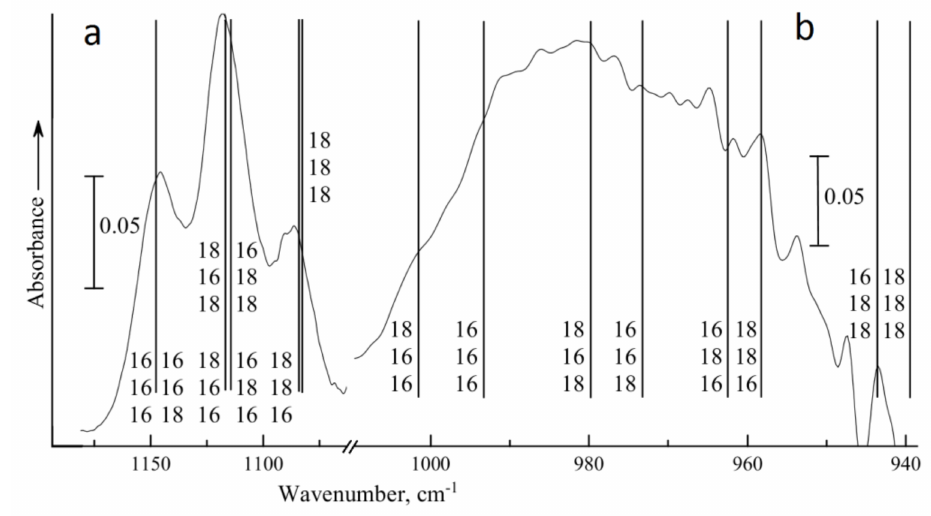
Figure 4. Experimental spectrum of isotopically mixed ozone with 50% 18 O content (solid curve) and the calculated frequencies (vertical lines) of 18 O-containing ozone complexes with a TiO 2 cluster in the regions of ν 1 ( a ) and ν 3 ( b ) vibrations. Masses of oxygen atoms number 1–3 are shown from bottom to top.